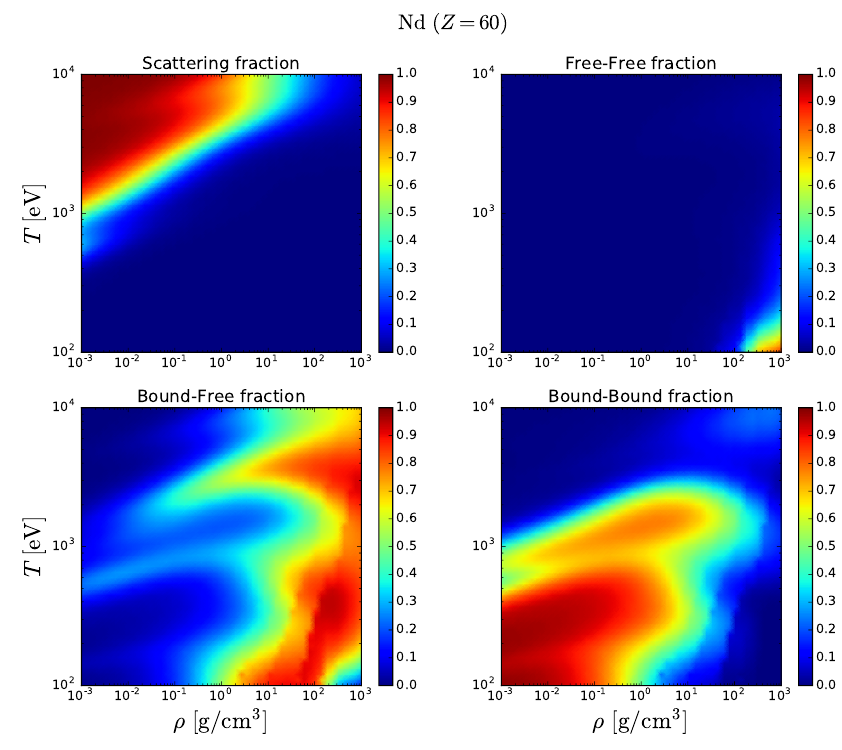
Figure 8. Same as Figure 7, for